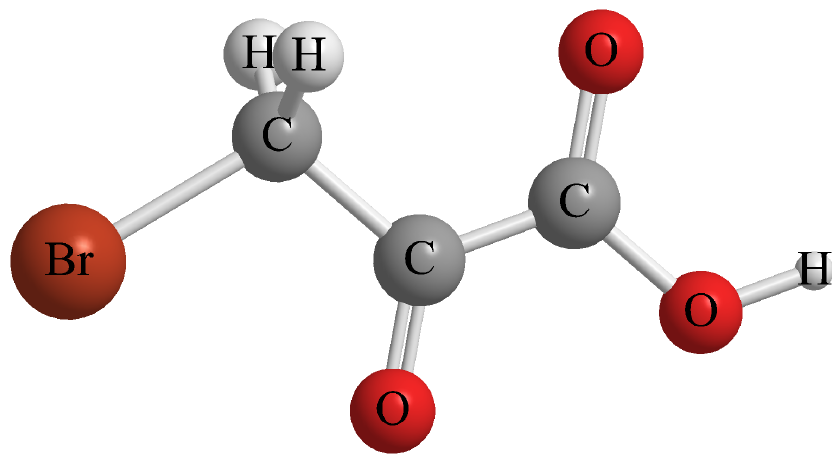
Figure 1. Chemical structure of 3-BrPA.